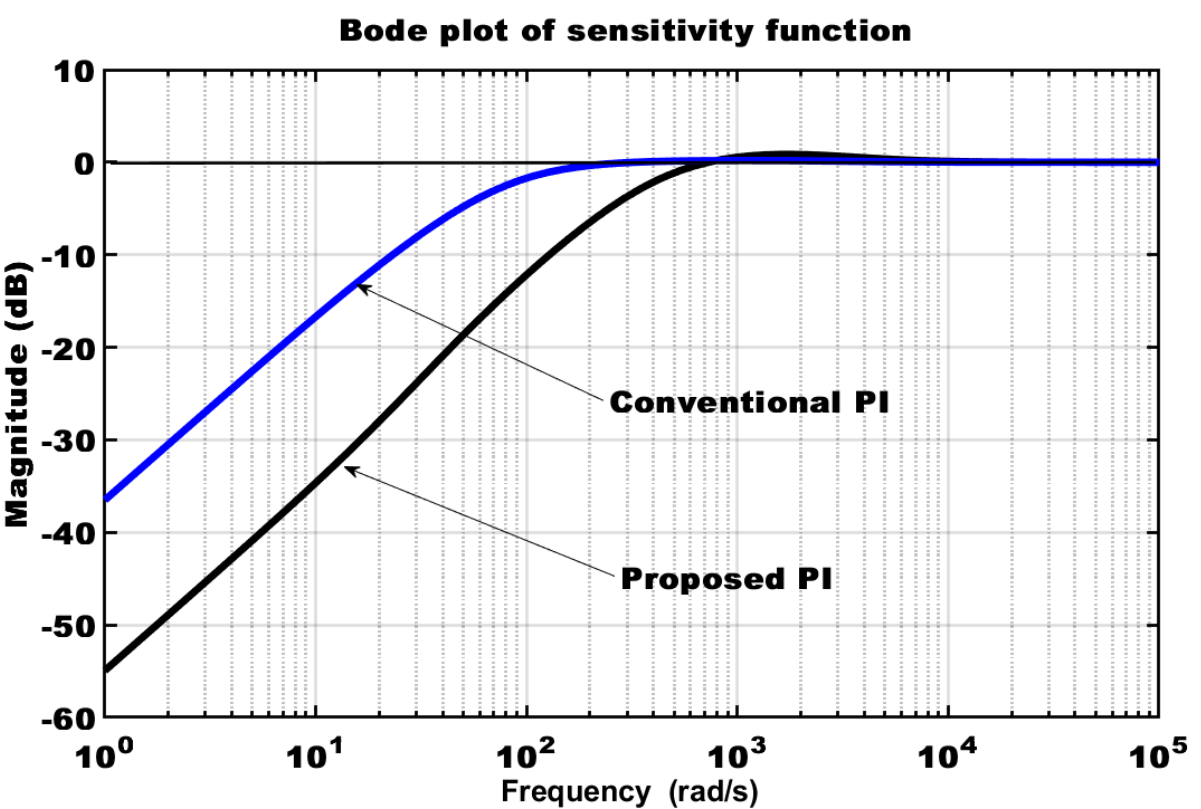
Figure 9. Comparative Bode plot of sensitivity function.